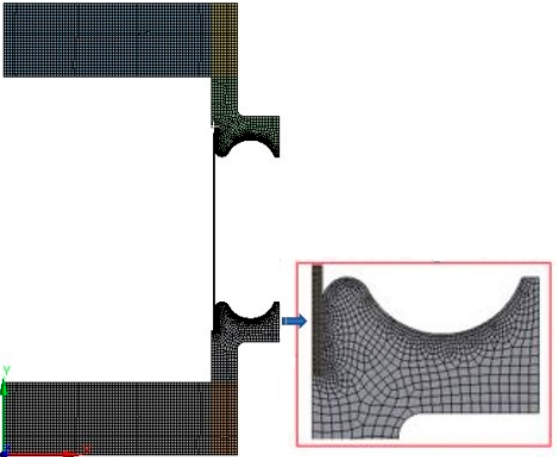
Figure 2. Mesh model of bellows for hydroforming process simulation.